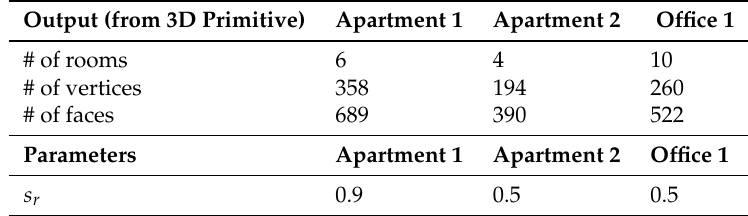
Table 2. Statistics of the output models.